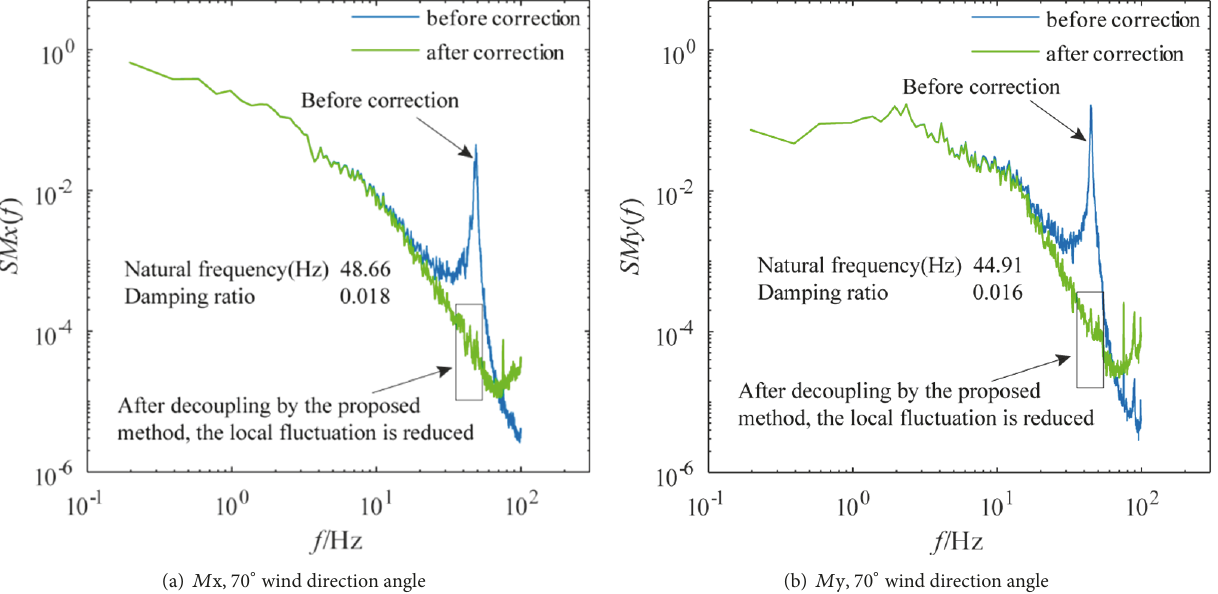
Figure 11: The correction effect of the base overturning moment of Guangzhou East Tower at 70 ∘ wind direction angle after